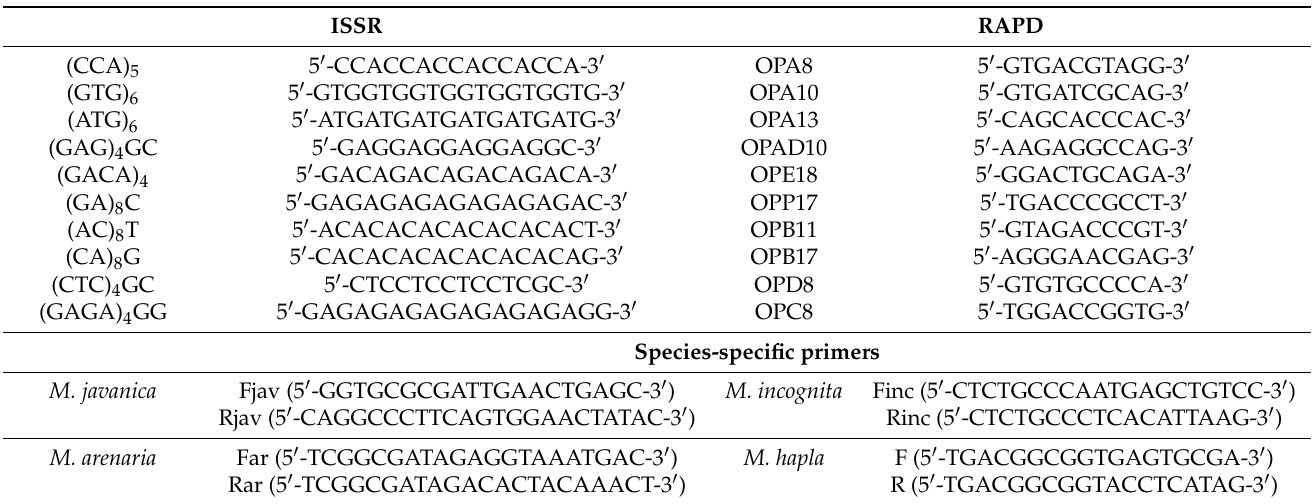
Table 2. The species-specific and ISSR, RAPD primers used for Meloidogyne species. ISSR